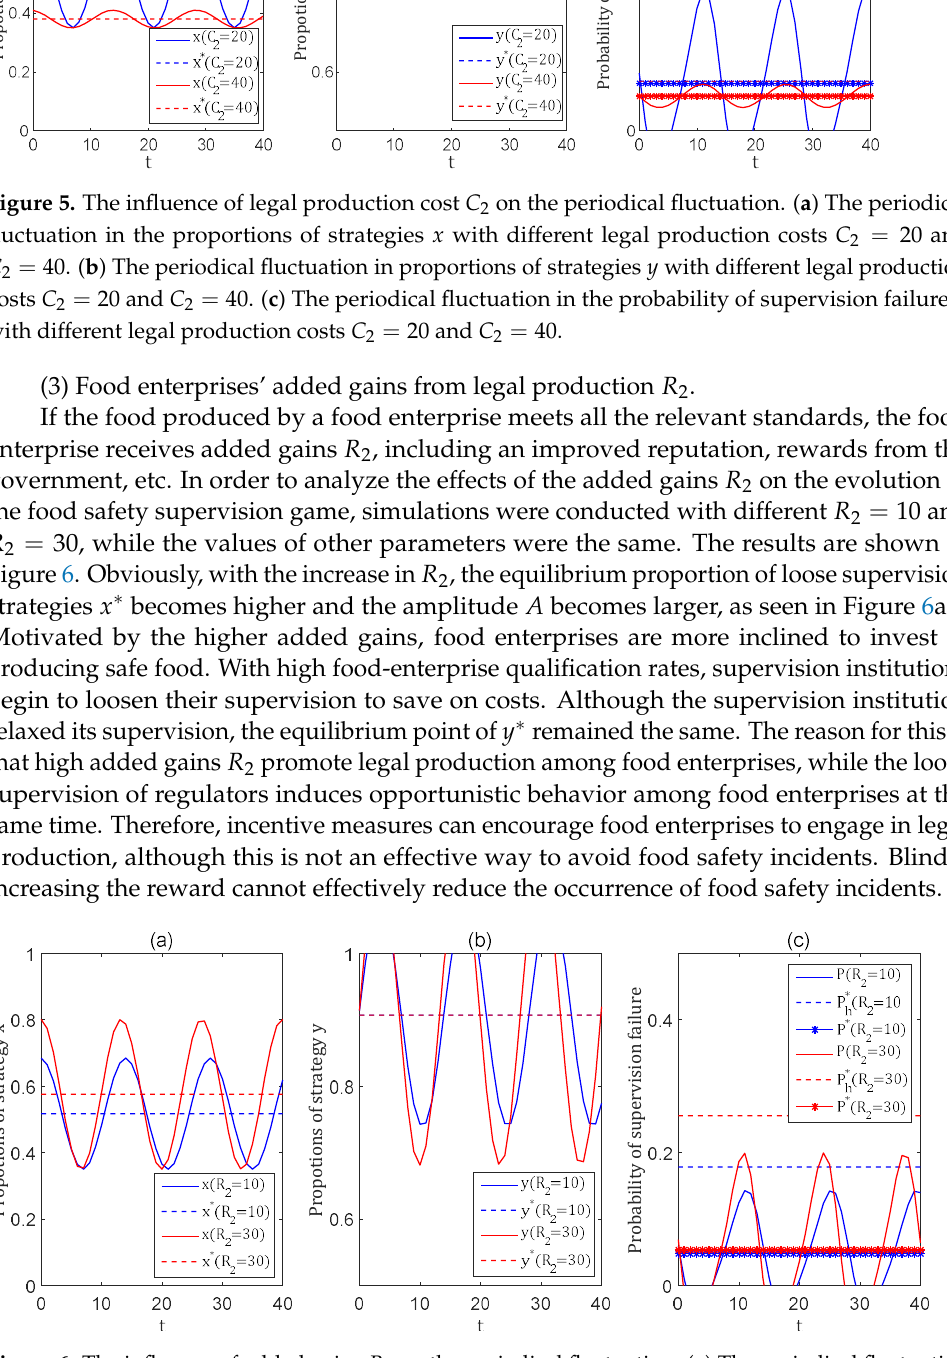
Figure 6. The influence of added gains R 2 on the periodical fluctuation. ( a ) The periodical fluctuation in the proportions of strategies x with different added gains R 2 = 10 and R 2 = 30. ( b ) The periodical fluctuation in proportions of strategies y with different added gains R 2 = 10 and R 2 = 30. ( c ) The periodical fluctuation in the probability of supervision failure P with different added gains R 2 = 10 and R 2 =